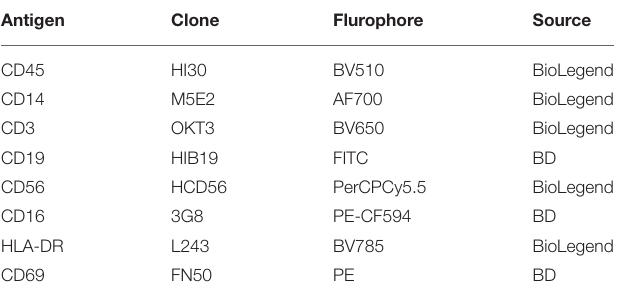
TABLE 1 | Antibodies used for flow cytometric staining.